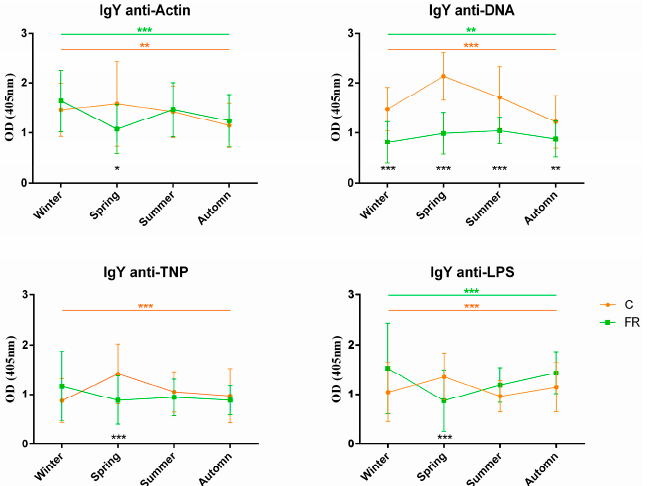
Figure 4. IgY NAb levels for fast- and slow-growth broilers across seasons: IgY NAb levels for the FR (Sasso, n = 210) and C (Ross 308, n = 210) groups were estimated by the binding capacity of serum NAbs to actin, DNA, TNP and LPS. OD values (mean ± SD) are given on the y axis for each year, with season on the x axis. Colored asterisks indicate significant differences among seasons for every genotype, while black asterisks indicate significant differences between the two genotypes ( p < 0.01 **, p < 0.001 ***).